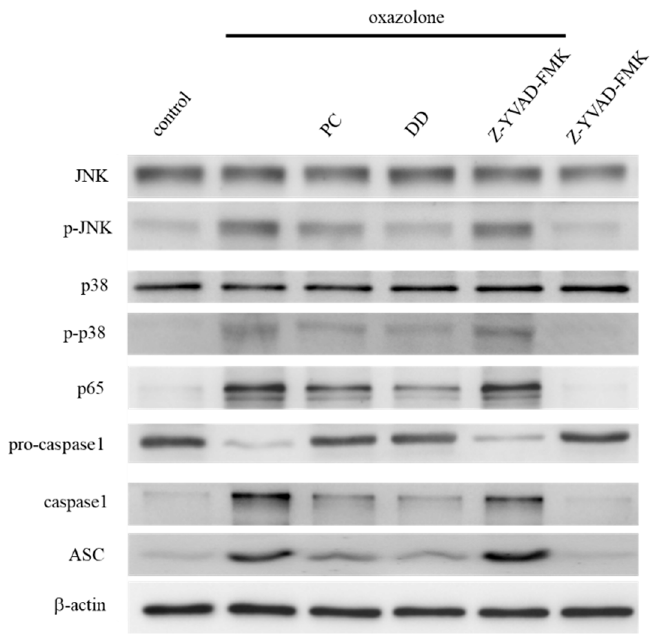
Figure 3. Effects of P. cicadae and D. dasycarpus on oxazolone-irritated inflammation in HaCaT cells. The HaCaT cells stimulated by oxazolone were cultured with either P. cicadae or D. dasycarpus. The relative activation of JNK and p38 was determined by Western blotting, and the levels of JNK and p38 were used as an indication of equal loading. Caspase-1, procaspase-1, ASC and p65 expression in HaCaT cells lysates was measured by immunoblotting, whereas β -actin was used as a loading control. Mitochondria are potential organelles for NLRP3 inflammasome activation because of their vital role in the production of ROS. Western blotting analysis revealed that the 20 kDa form of caspase-1 was present in cell lysates after an overnight treatment with oxazolone. Our results further confirmed that oxazolone could activate the NLRP3 inflammasome and stimulate the maturation of procaspase-1. The D. dasycarpus downregulated the capacity of oxazolone, including the inhibition of the expression